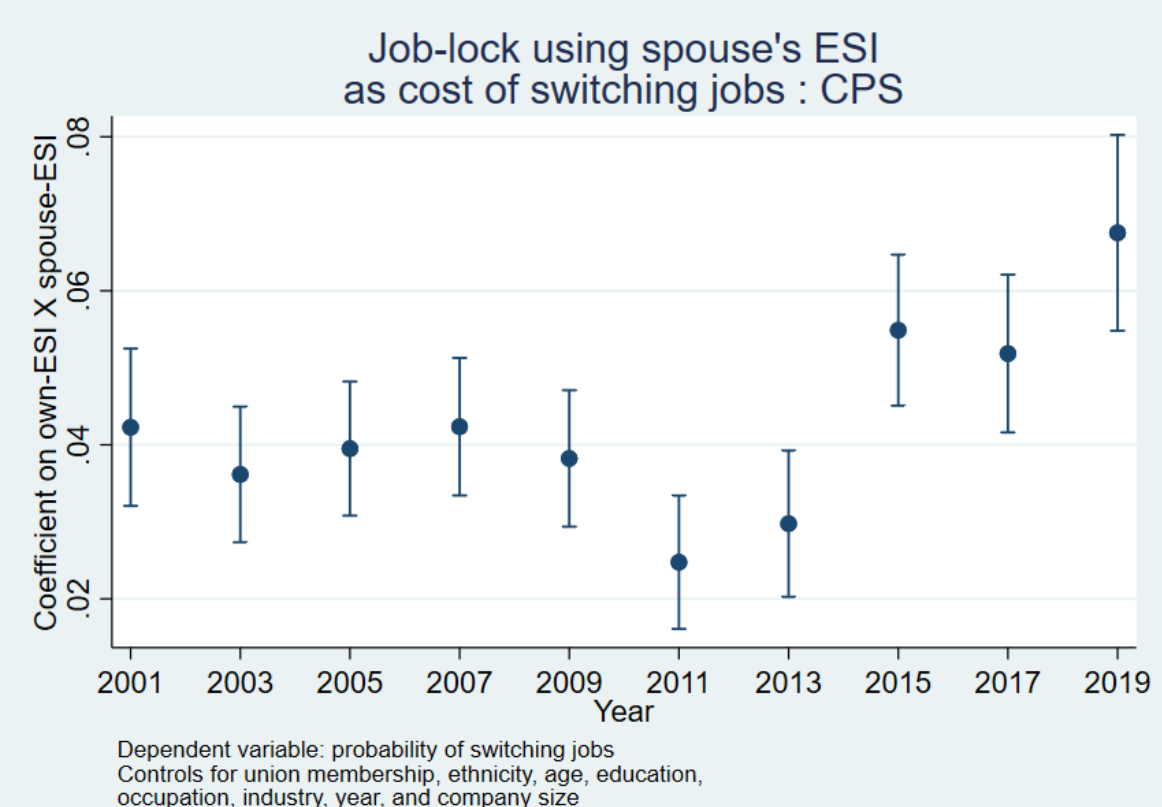
Figure 4. Period-Specific DD Estimates of Job Lock from the CPS.